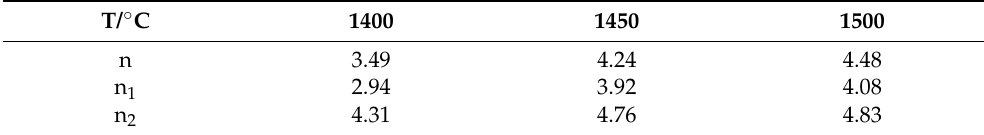
Figure 6. Os samples sintered at different temperatures ( a ) Relative shrinkages; ( b ) sintering kinetic curves. Table 2. Values of n in the sintering kinetic equation.